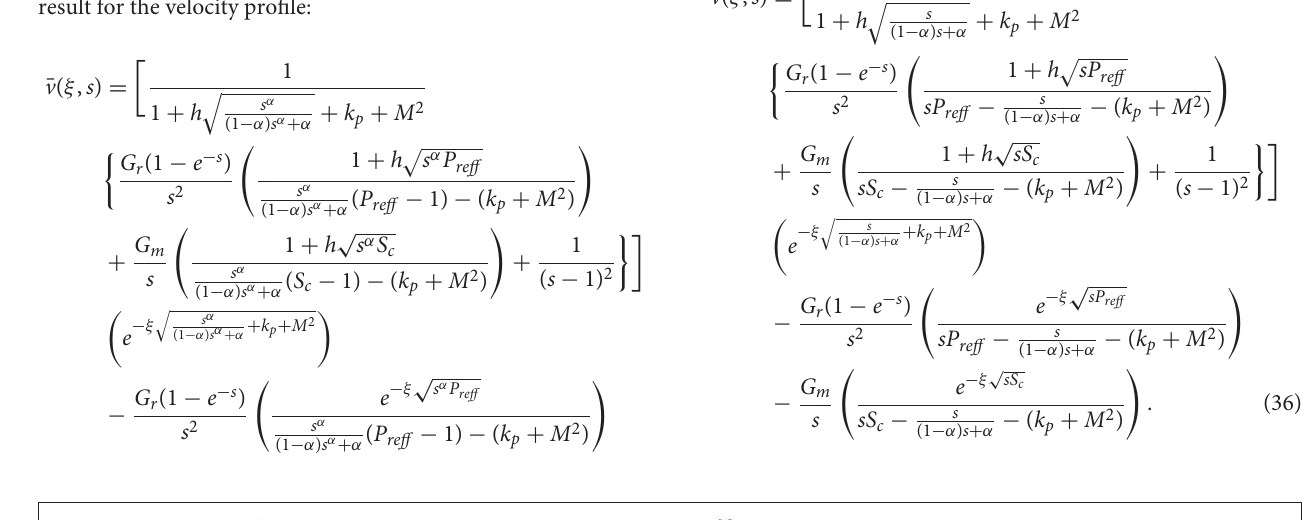
Frontiers in Physics |